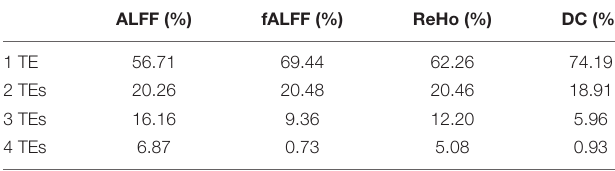
TABLE 2 | The DOCs of ALFF, fALFF, ReHo, and DC for voxels that appeared in the T maps between EO and EC of only one TE dataset, any two TE datasets, any three TE datasets, and all the four TE datasets,